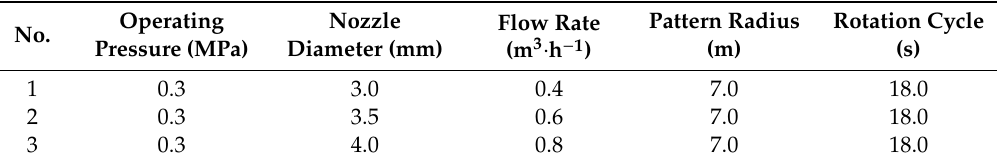
Table 1. Technical parameters of the sprinkler.